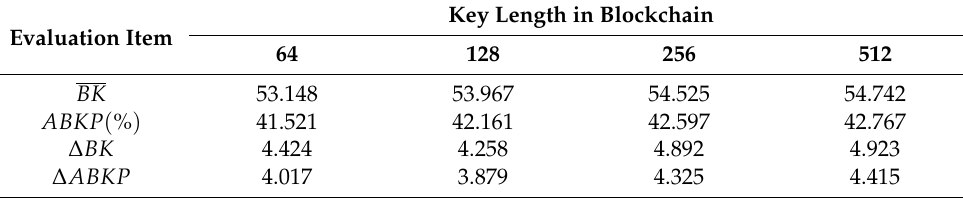
Table 9. Rate of change according to blockchain